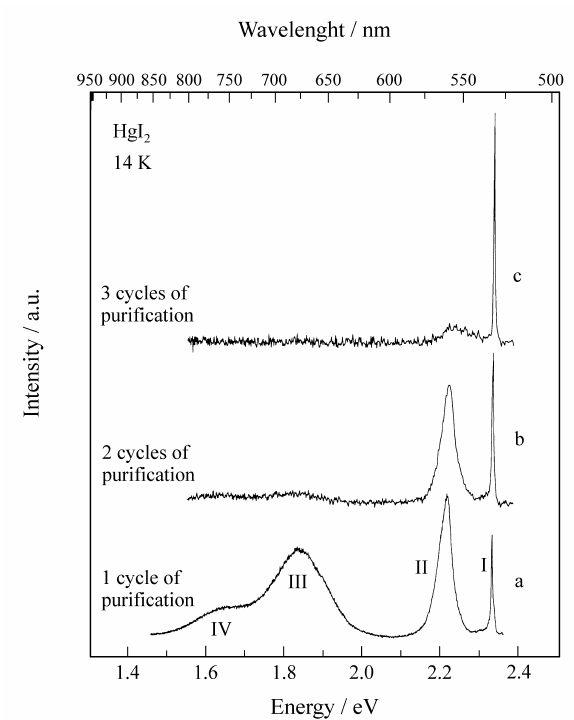
Figure 3. Photoluminescence spectra of α -HgI 2 samples grown after three different purification procedures. Measurements were carried out perpendicularly to the (001) crystalografic